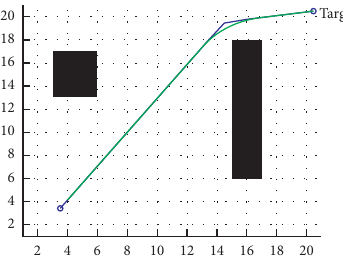
Figure 13: The generation of the Bezier curve